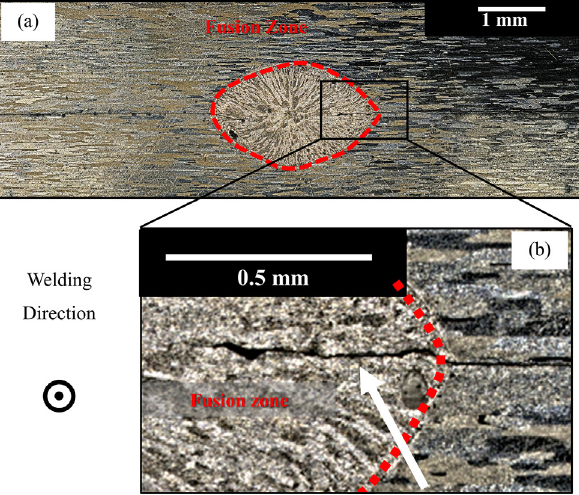
Figure 2: Macroscopic photographs of a laser pressure welded AA 2198. (a) OM image of the cross section cut perpendicular to the welding direction; (b) enlarged OM image of the unwelded region in the fusion